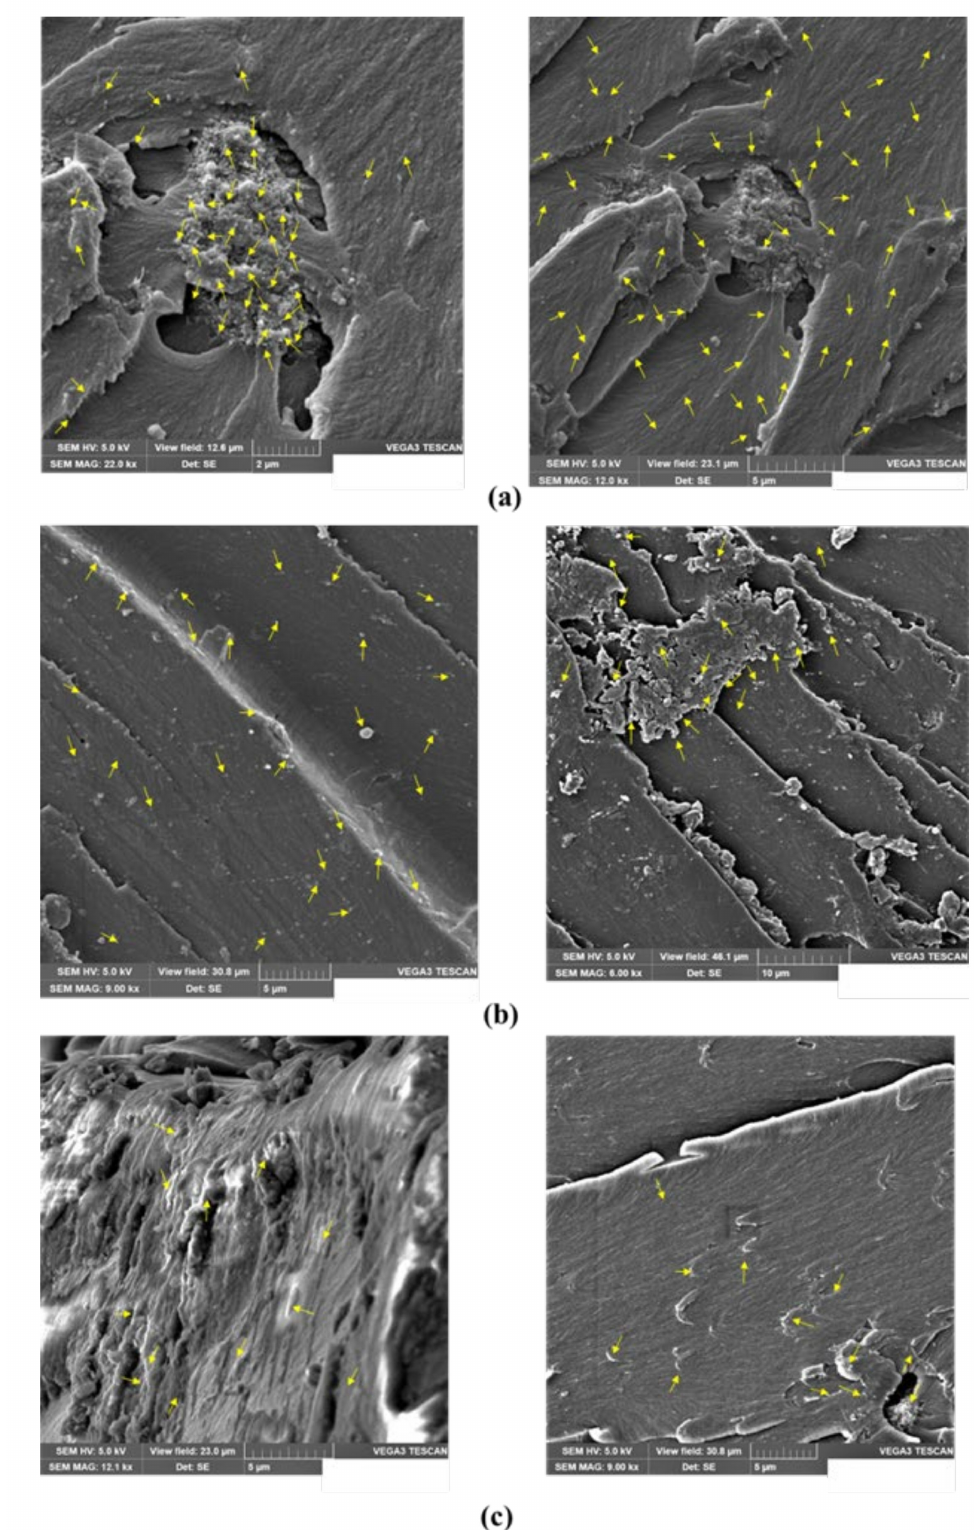
Figure 5. Scanning electron micrograph showing hardened vinyl ester incorporating ( a ) 0.50 wt.%, ( b ) 1.0 wt.%, and ( c ) 2.0 wt.% COOH-MWCNTs with ( left ) high magnification ( right ) low